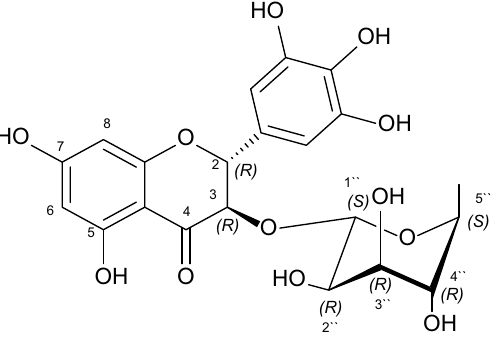
Figure 1. Structure of 2 R , 3 R , 1´´ S , 2´´ R , 3´´ R , 4´´ R , 5´´ S dihydromyricetin 3- O -rhamnoside ( 1 ).